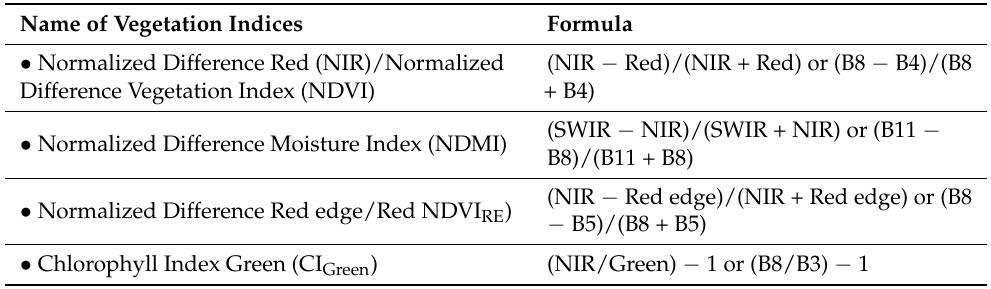
Table 1. Vegetation Indices Formula. Name of Vegetation Indices